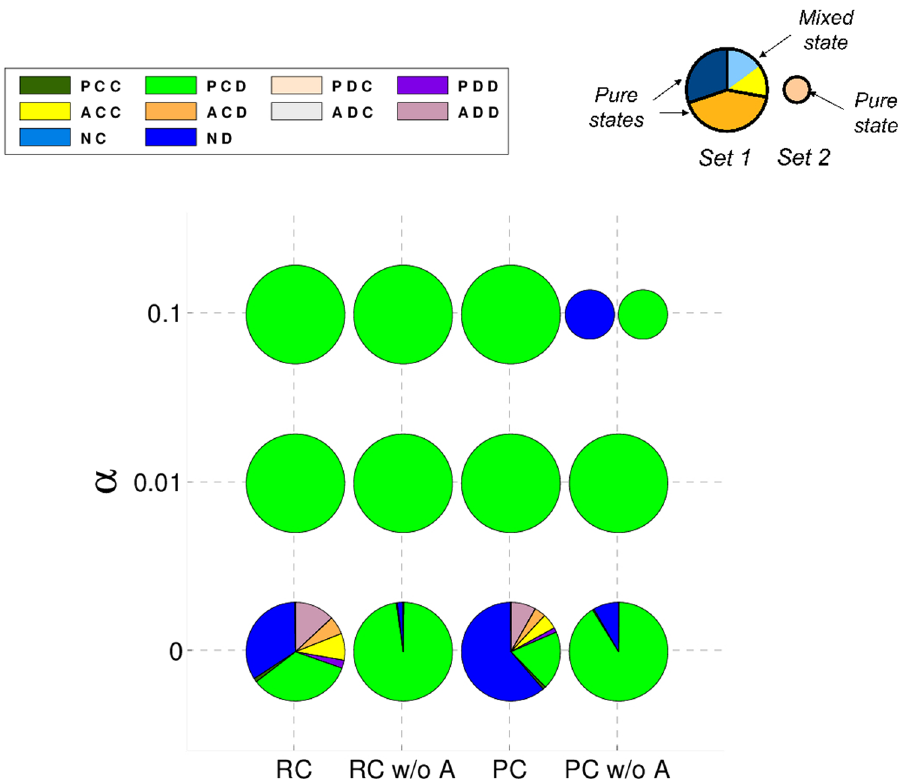
Figure 4. No mixed states are formed in repeated games. Acceptors reduce cooperation in the absence of noise. Composition of the recurrent sets for repeated games without forgiveness. Strategies represented as in Fig. 1 for RC and PC repeated games for different values of α . Different pies for a given game stand for different attractors. We assumed  = 0.25 and δ =